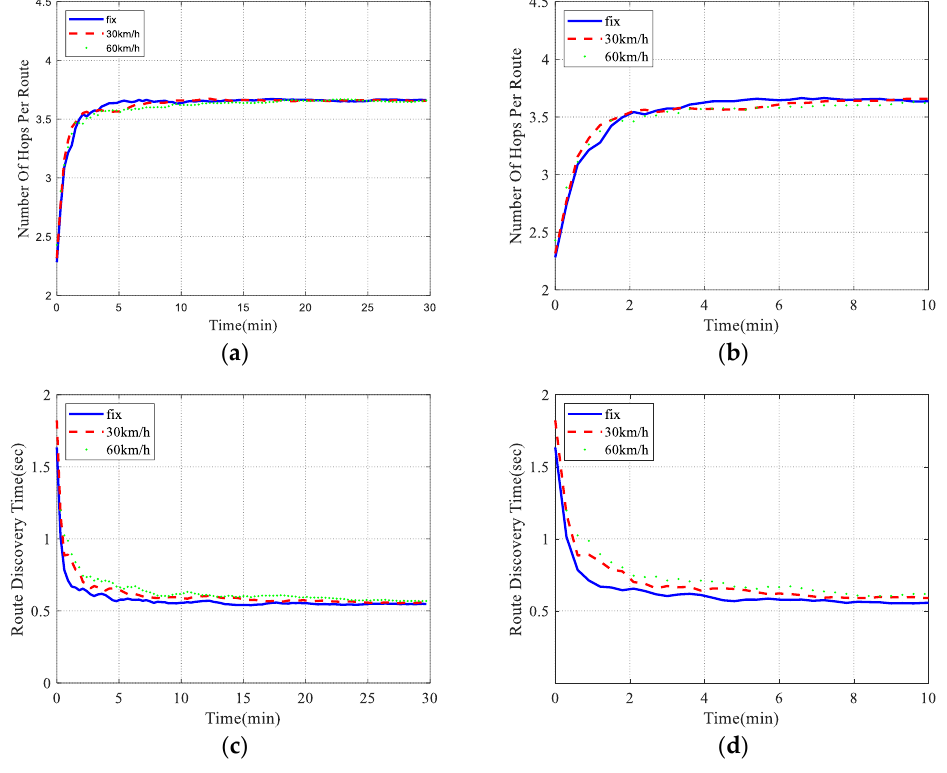
AODV initiates routes on demand, so it needs to bypass the damaged nodes to find